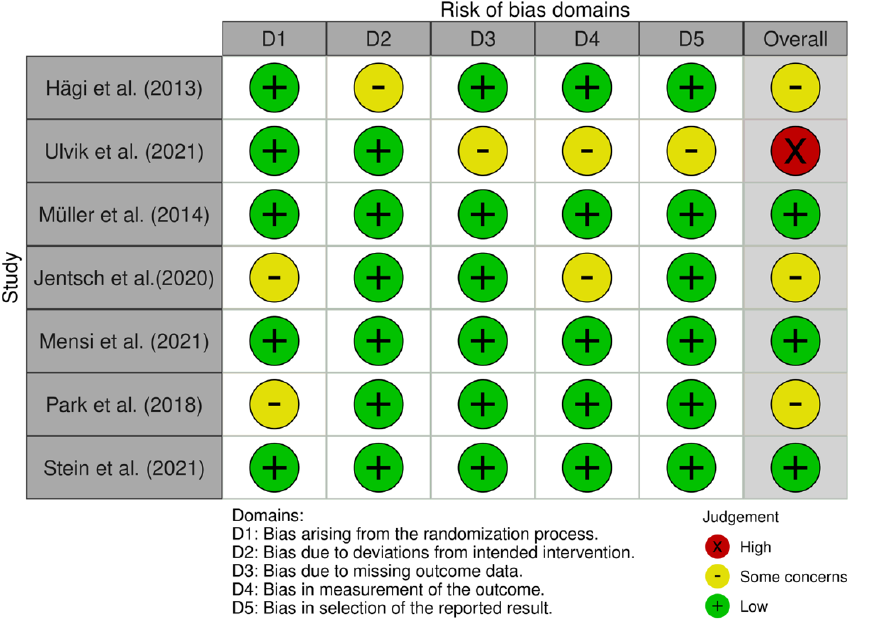
Figure 2. Cochrane RoB quantification [11–17].